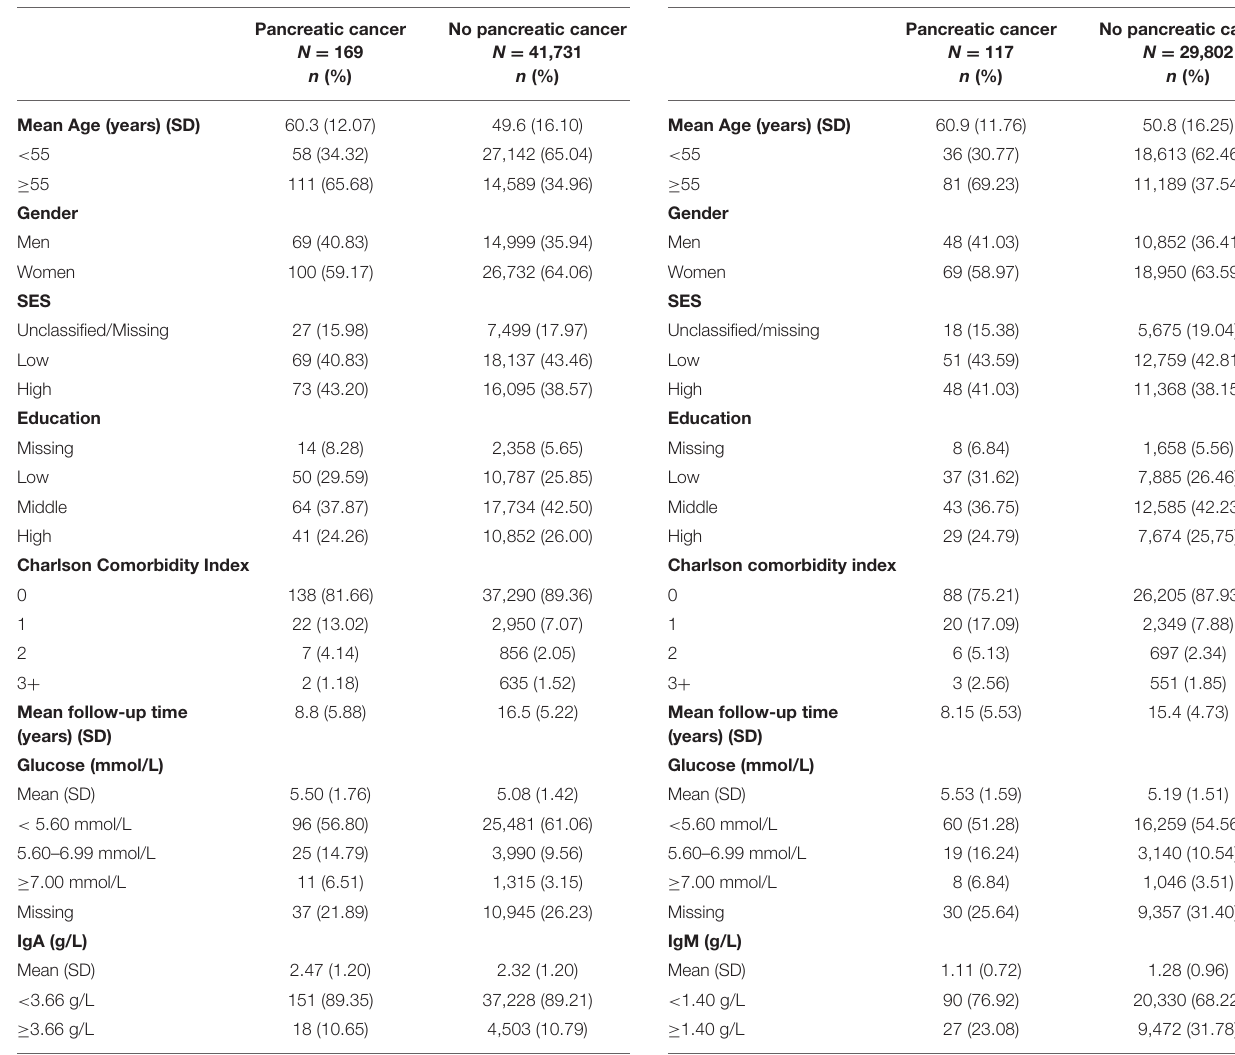
TABLE 4 | Descriptive statistics of study population with a measurement of IgA. TABLE 5 | Descriptive statistics of study population with a measurement of IgM.